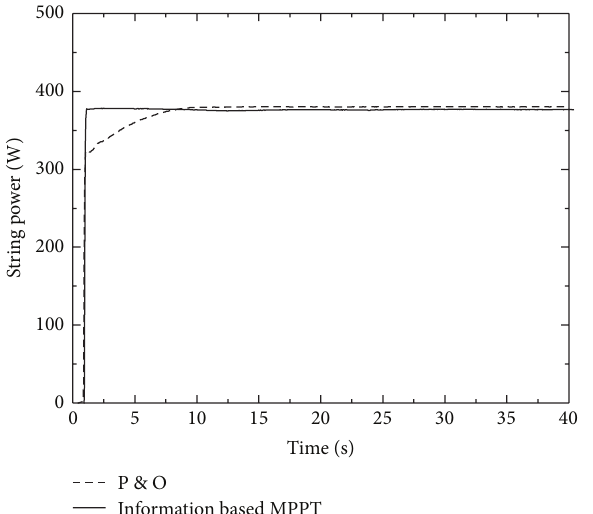
Figure 12: Comparison of string power behavior against the time corresponding to both P&O (dashed line) and information based MPPT (solid line) algorithms.